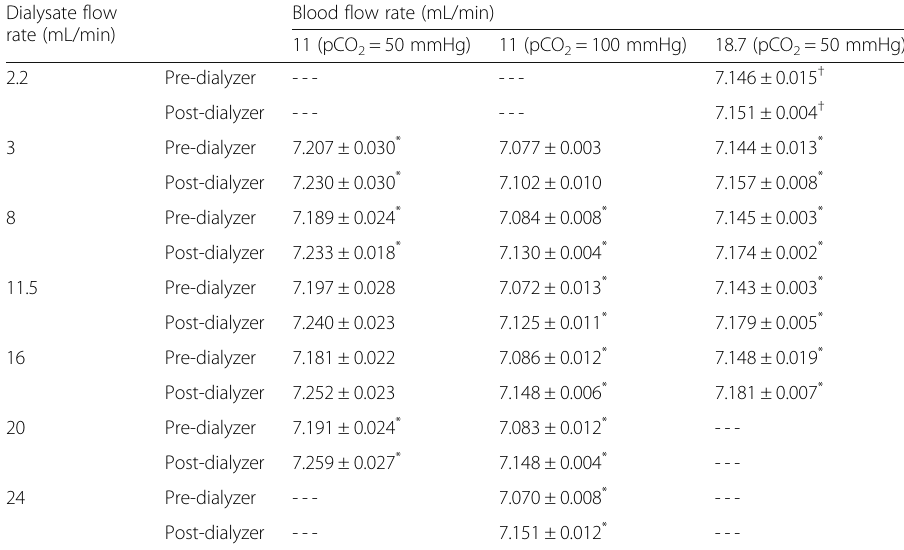
Table 2 pH of pre- and post-dialyzer blood Dialysate flow rate